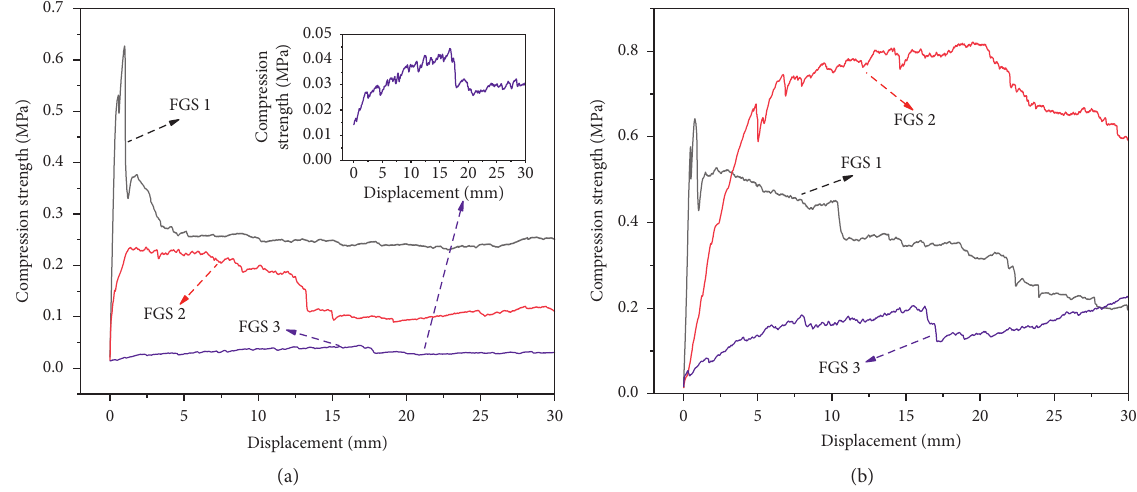
Figure 13: Compressive strength-displacement curve for OPC foam cement filling materials. (a) 1d, (b) 7d.